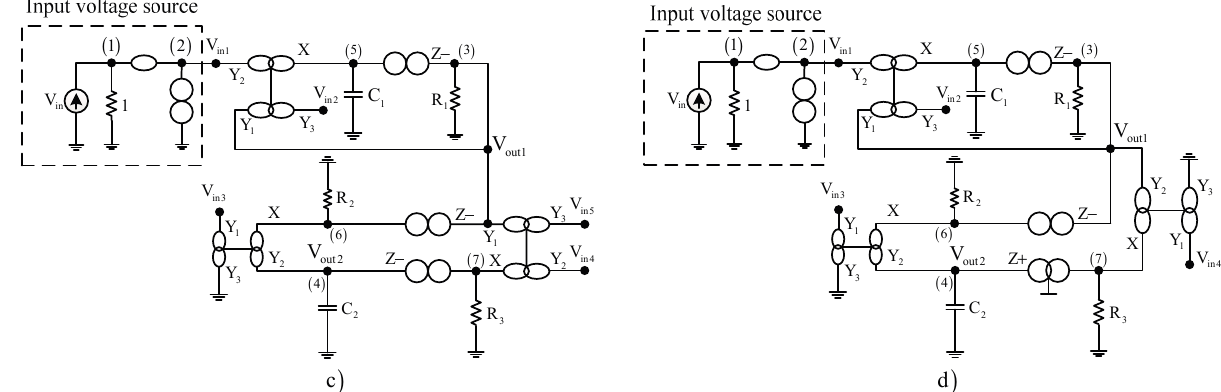
Figure 3. The pathological representations of derived type-A filters (cases